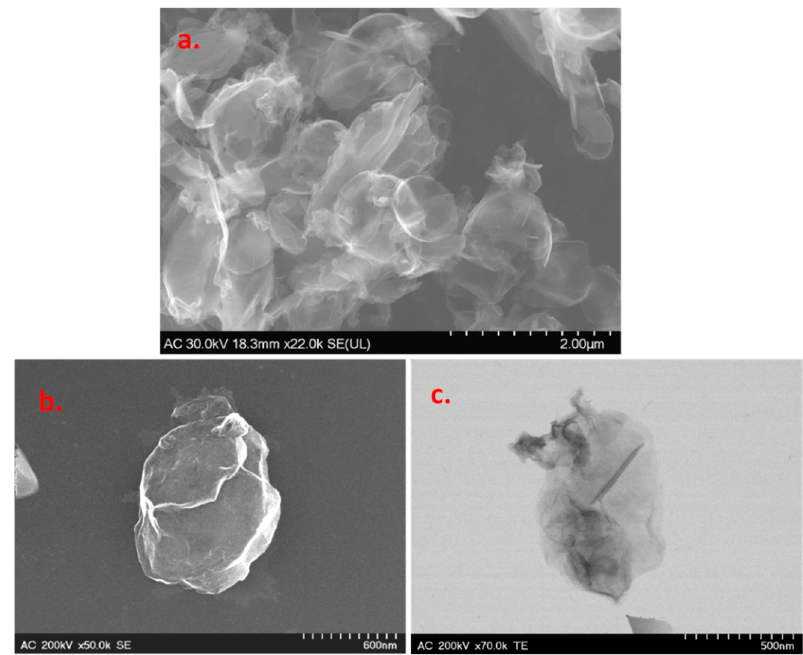
Figure 2. Representative SEM ( a , b ) and TEM ( c ) images of the graphene sample .